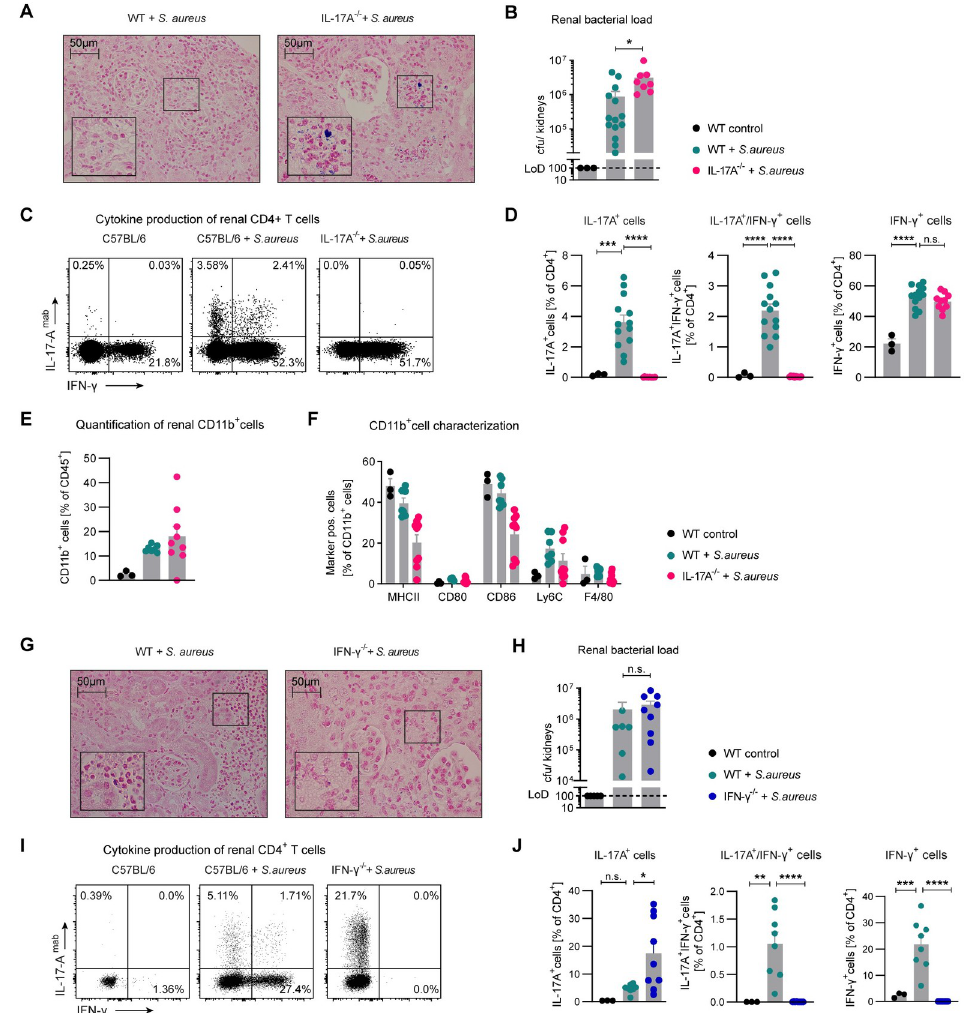
Fig 2. IL-17A-deficient mice show highest bacterial burden in comparison to WT and IFN- γ -deficient mice. (A) Gram staining of kidney sections from C57BL/6 and IL-17A-deficient mice 10 days after S . aureus infection. (B) Quantification of bacterial load in kidneys as indicated; bars representing mean; individual mice displayed by dots ( � p < 0.05 in Mann-Whitney test). (C and D) Flow cytometry of renal CD4 + T cells at day 10 after S . aureus infection. (E) Quantification of renal CD11b + cells of CD45 + cells and (F) characterization of renal CD11b + cells at day 10 after S . aureus infection (representative for one of three independent experiments). (G) Gram staining of kidney sections from C57BL/6 and IFN- γ -deficient mice 10 days after S . aureus infection. (H) Quantification of bacterial load in kidneys as indicated ( � p < 0.05 in Mann-Whitney test). (I and J) Flow cytometry of renal CD4 + T cells of C57BL/6 and IFN- γ - deficient mice 10 days after S . aureus infection (pooled data from two independent experiments). Bars representing mean ± SEM, individual mice displayed by dots; not significant (n.s.), � p < 0.05, �� p < 0.01, ��� p < 0.001, ���� p < 0.0001 in Dunnett’s multiple comparison one-way ANOVA analysis.